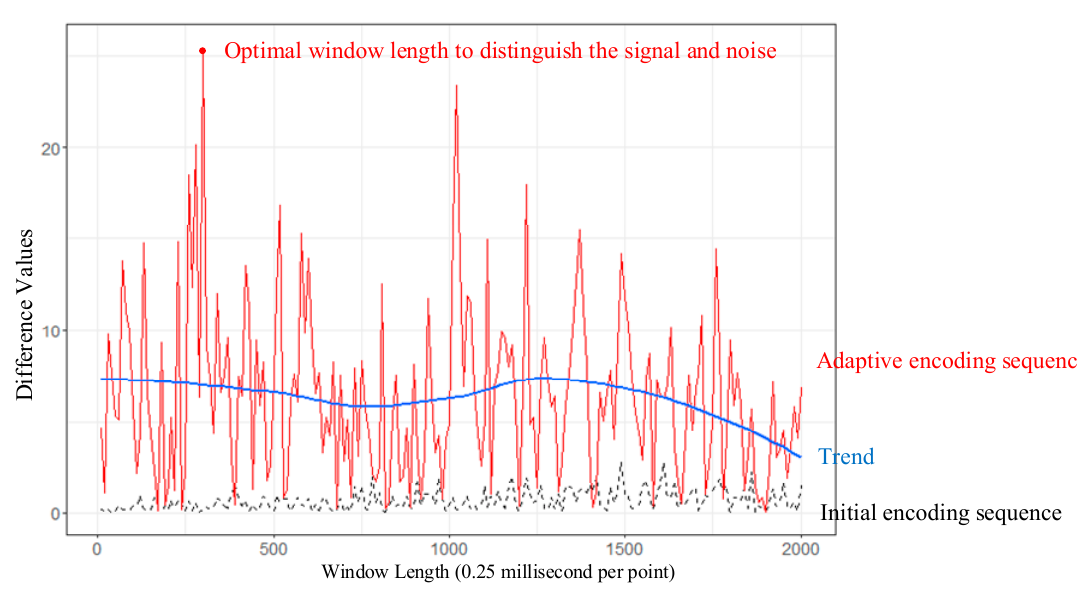
Figure 6. The relationship between the window length and the AMNBP differences.